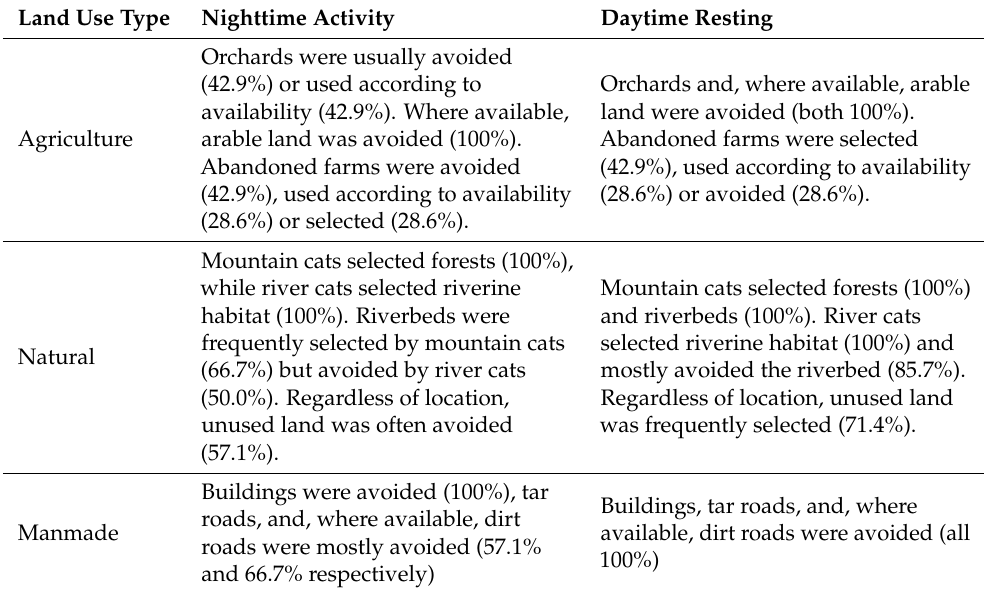
Table 6. Description of land use types selected by leopard cats for nighttime activity versus daytime resting, percentages between brackets represent the percentage of studied leopard cats which showed this selection pattern for the land use types available within their home